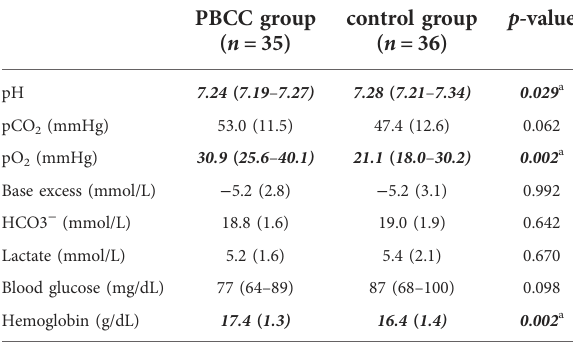
TABLE 2 Umbilical artery blood parameters in PBCC and control group. Data are presented as mean (SD) or median (IQR). PBCC